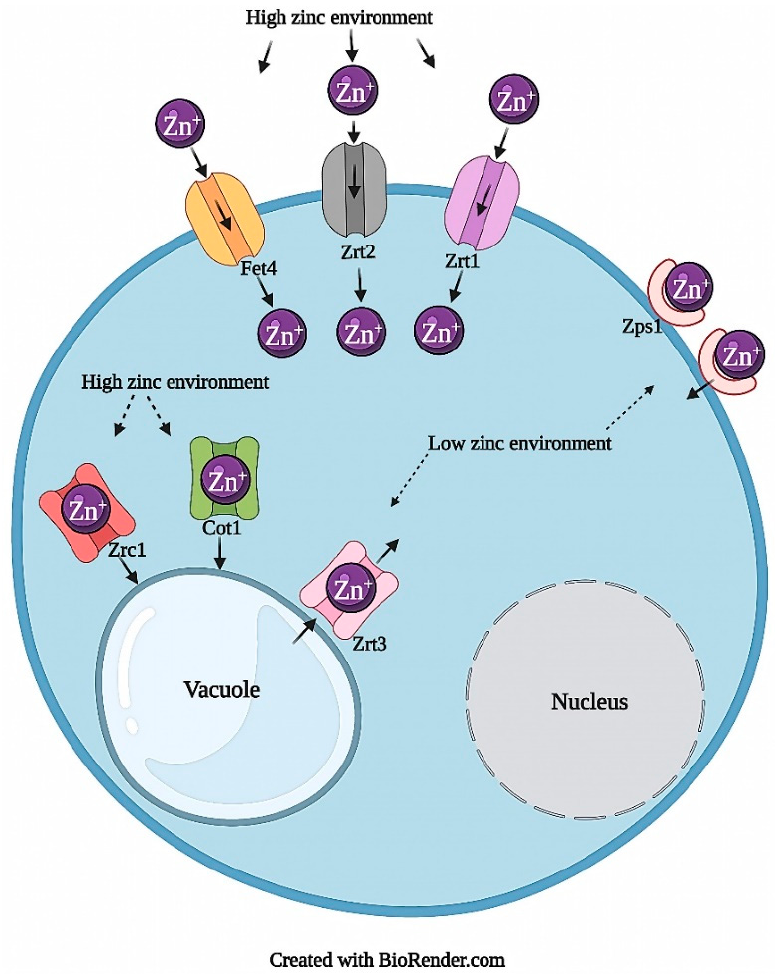
Figure 1. S. cerevisiae zinc homeostatic systems.